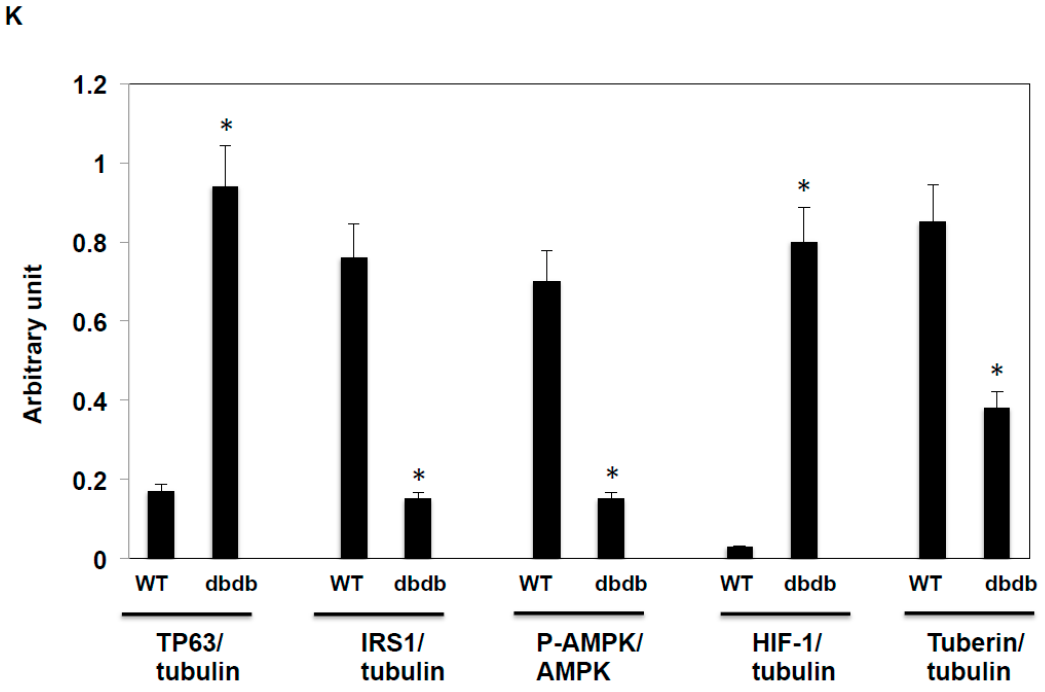
Figure 2. Increased expression of TP63 is associated with a decrease in insulin receptor substrate 1 (IRS-1), phospho-AMP-activated protein kinase (p-AMPK), and tuberin in kidneys of diabetic mice. ( A , B ) Data from diabetic kidneys showed an increase in TP63 expression and a decrease in IRS-1 expression compared to WT mice at 10- and 12-months-old. ( C – F ) Immunofluorescence staining confirmed increased expression of TP63 in diabetic mice of 10- and 12-month-old age compared to WT. Note that the majority of TP63 staining was localized within tubular cells (marked with arrows). ( G , I ) Increased expression of TP63 is associated with a decrease in p-AMPK expression in 10- and 12-month-old diabetic mice, compared to WT mice. ( H , J ) Increased expression of TP63 is also associated with a higher expression of HIF1a and a lower expression of tuberin in diabetic mice compared to WT mice at both ages. ( K ) Histogram presented quantification Western blot data of each protein normalized by tubulin and p-AMPK normalized by AMPK of 12 months old mice ( n = 4) groups. A significant difference from the WT group is indicated by * p < 0.01.